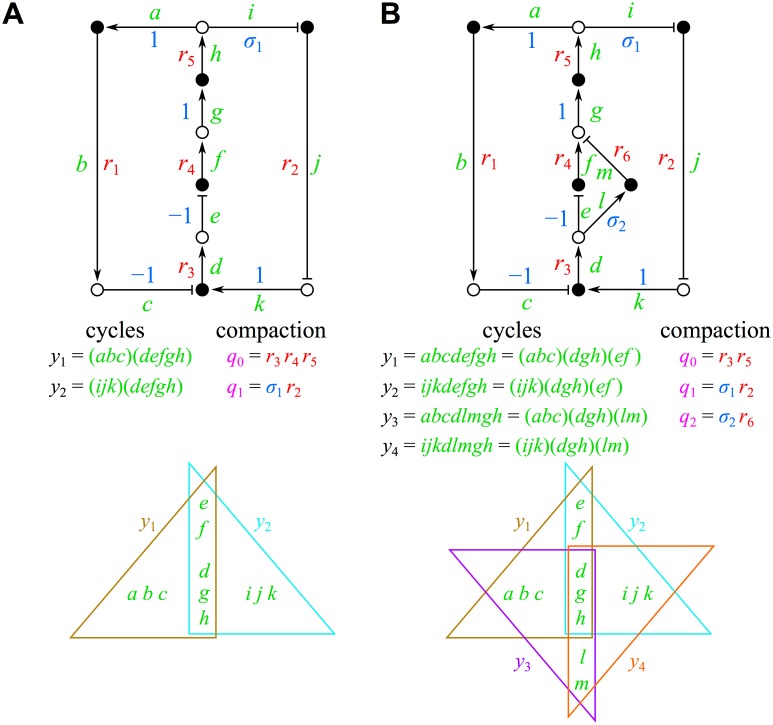
Cycle compaction.(A) For a network composed of two overlapping cycles, the possible cycle compaction terms (q
0 and q
1) are listed. (B) Upon slight modification of A, a network composed of four unique overlapping cycles is obtained, with now three possible compaction terms (q
0, q
1, and q
2). The collection of edges that contribute to the non-overlapping and overlapping parts of the influence topology cycles for each network are shown as Venn diagrams at the bottom of each panel. See §3 for further details.